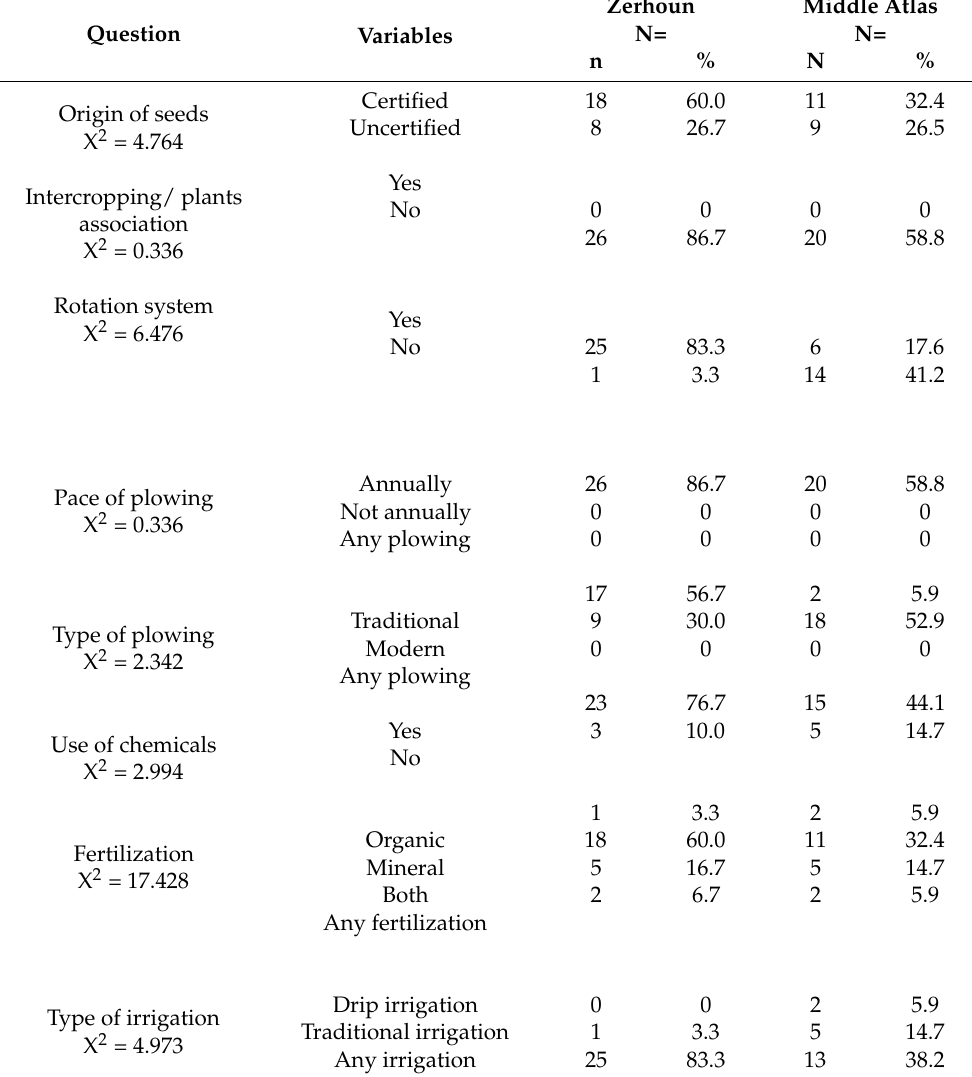
Table 4. Agricultural practices—cereals and